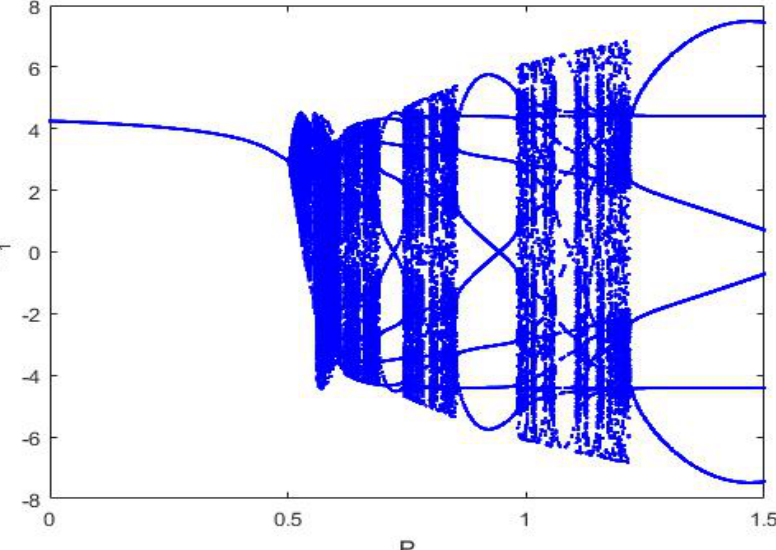
Figure 3. Bifurcation diagram versus the parameter P of the D.T.H.N.N with incommensurate fractional V.O